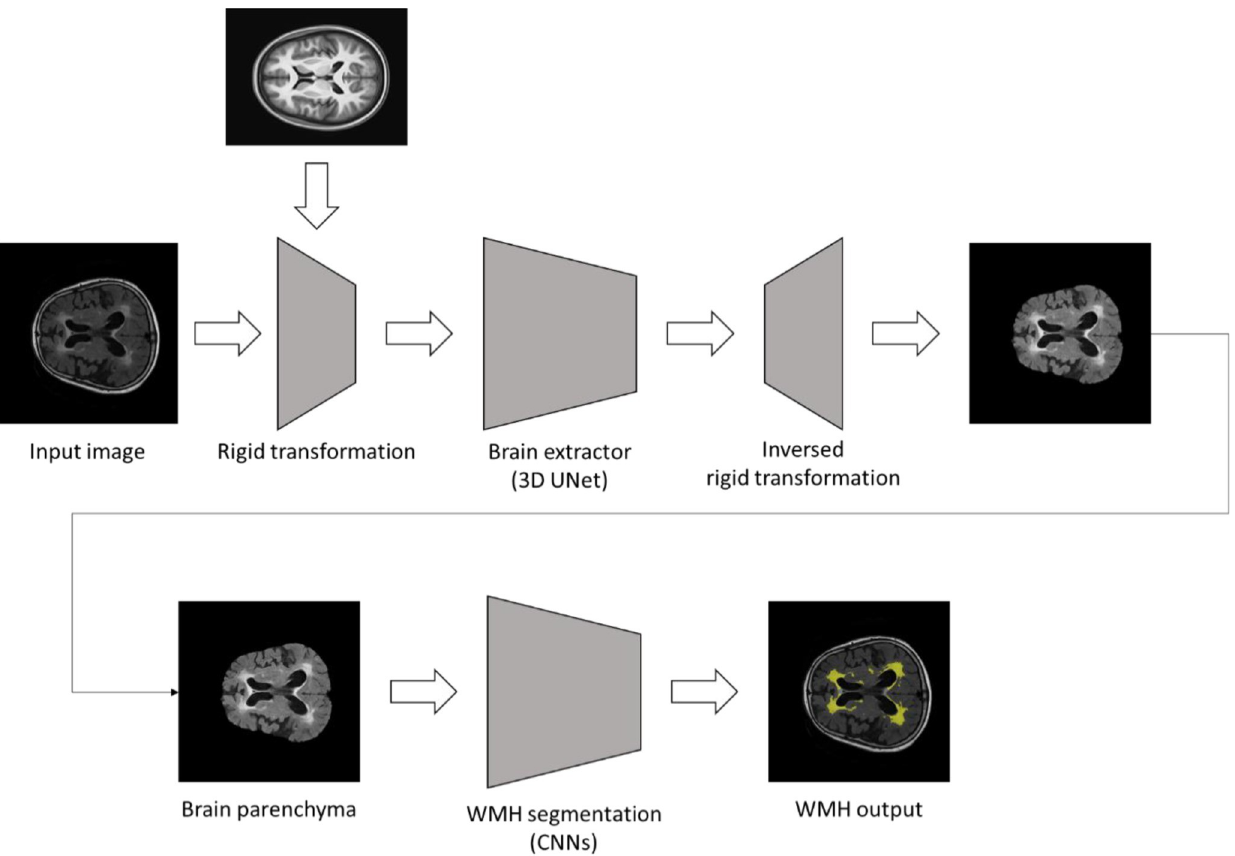
Fig 1. A schematic diagram of the deep learning-based WMH segmentation algorithm. The deep learning-based WMH segmentation algorithm is consisting of two independent processes. First, brain extraction is conducted with two rigid transformation and in-house brain extraction algorithm using 3D U-Net. Second, in-house convolutional neural networks segment WMH from the preprocessed brain parenchyma image.